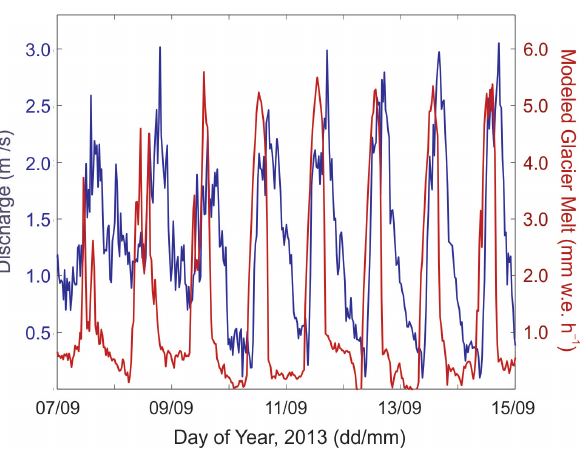
Figure 10. Discharge in Haig Stream (blue, m 3 s − 1 ) and modelled glacier melt rates (red, mmw.e.h − 1 ) , 7–14 September